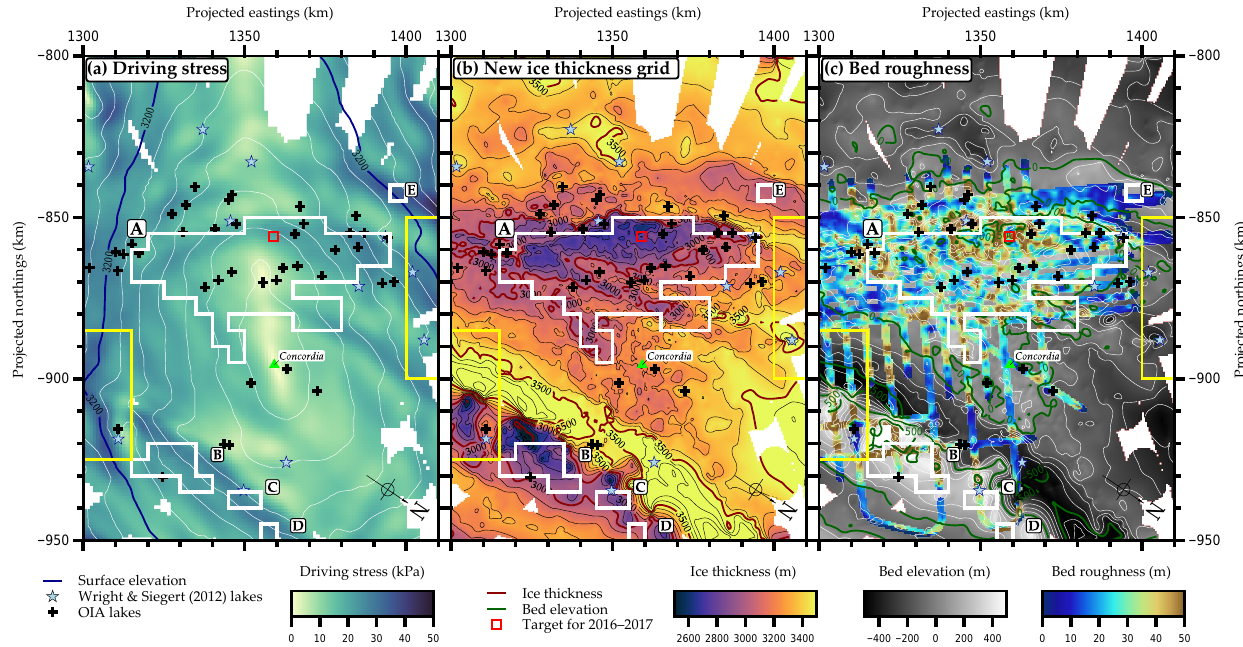
Figure 5. The Dome C old ice candidates in the context of updated data sets. New subglacial lakes, identified using specularity content, are shown as black crosses; regions of surface–bed disagreement in Bedmap2 are shown in yellow. (a) Driving stresses using the new ice thickness data and the Cryosat-2 surface DEM (Helm et al., 2014; smoothed by 15km to remove longitudinal stress gradients) show that all of the candidates aside from the innermost portion of Candidate A lie over regions of relatively high (20–30kPa) driving stress (note that surface slope is the primary driver on driving stress here). (b) Compiled ice thickness data provided by ICECAP, AWI, BAS, and INGV. (c) RMSD of the bed at 800m length scale using OIA data only, superimposed on new bed elevations (in grayscale). The region tends to be rougher toward the center of the Candidate A region, and smoother toward the edges and in the troughs. Concordia Station (green triangle) lies in a particularly smooth area. Projection is Antarctic Polar Stereographic.